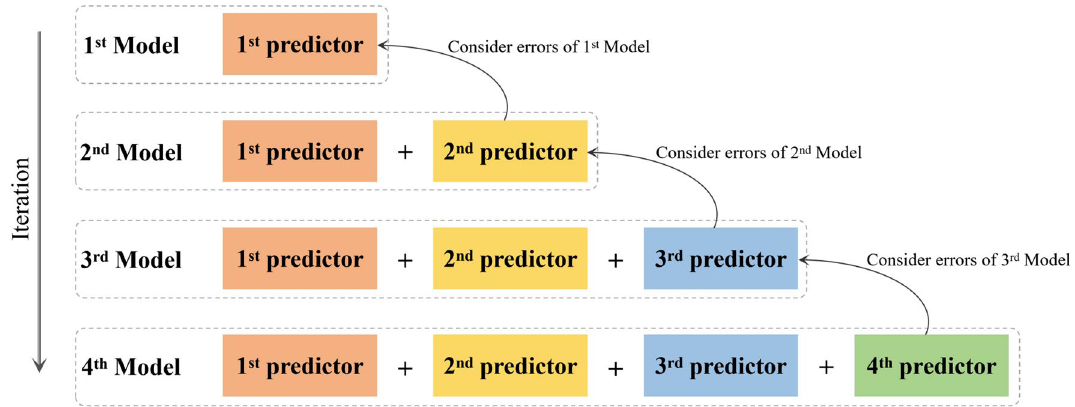
Figure 3. The illustration of XGBoost model for image classification. A predictor is trained to predict the errors made by the original model, and then construct an improved model whose output is fine-tuned based on the original